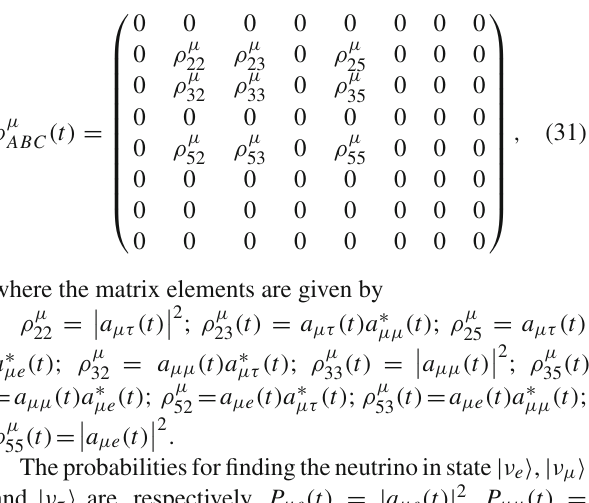
muon neutrino oscillation as a function of L / E with logarith- mic scale. While the transition probability of P μτ ( t ) shows a relatively large range of variation, the transition